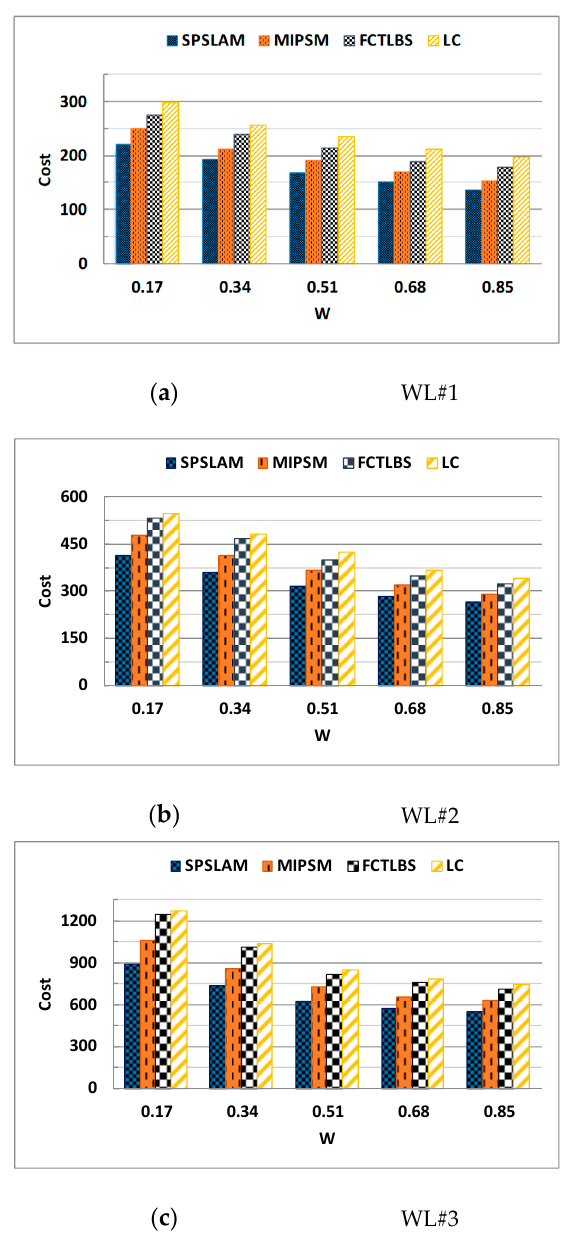
Figure 5. Scheduling cost under different deadlines.